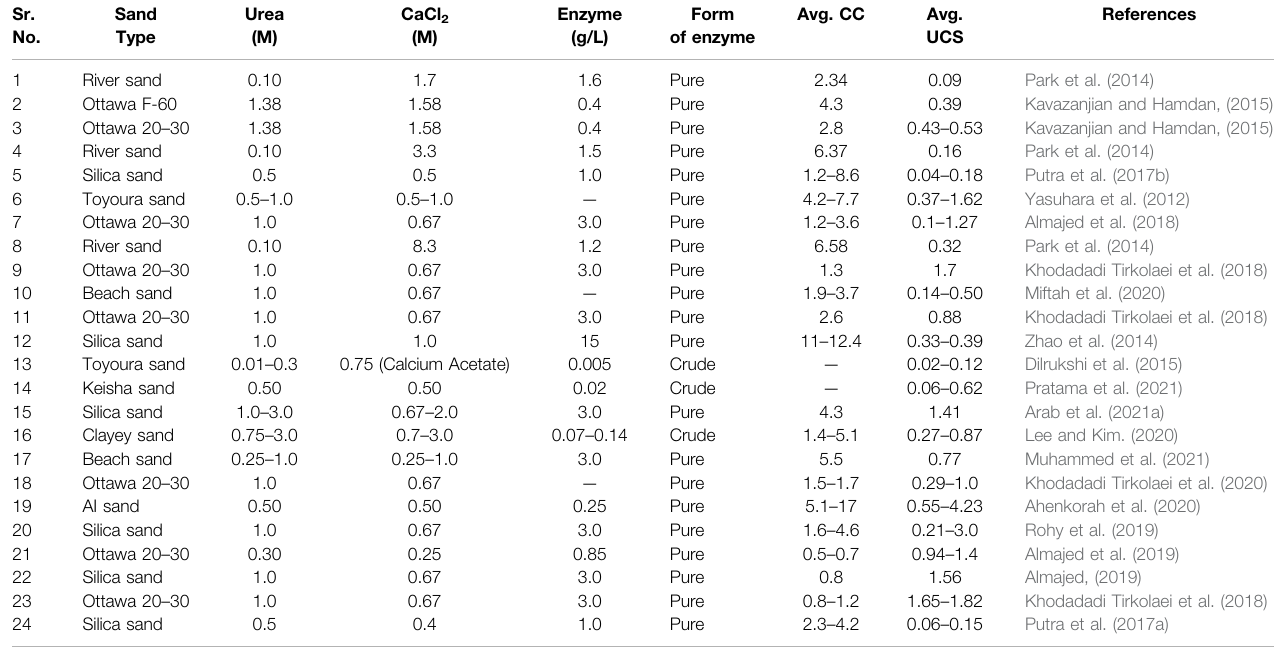
TABLE 3 | UCS and calcium carbonate precipitation (%) after EICP treatment reported in the literature. Sr.